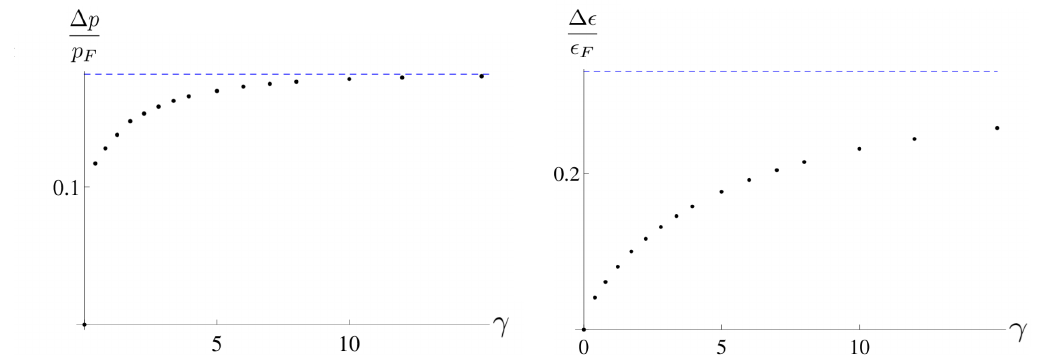
Figure 11: Upper bounds for the validity range in dimensionless momentum (left panel) and dimensionless energy (right panel) around the umklapp point p = 2 p liquid prediction for the excitation spectrum ε II , as functions of the dimensionless interac- tion strength γ . Dots represent the numerical estimate at finite interaction strength, the blue dashed curve is the exact result in the Tonks-Girardeau regime ∆ ε TG /ε ∆ p TG / p (cid:39) F